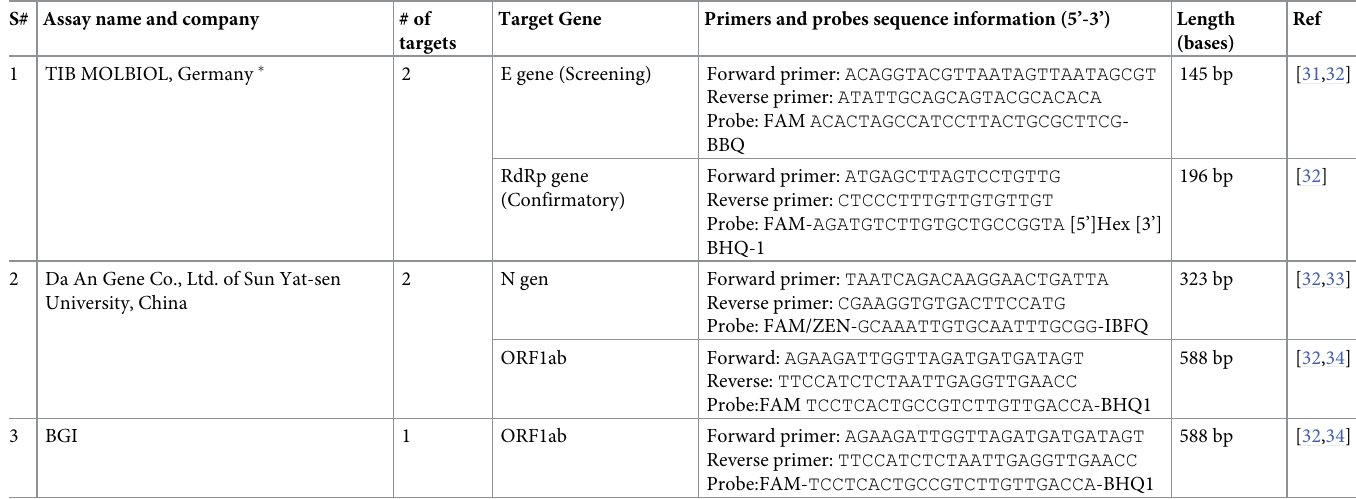
Table 1. RT-PCR test kits with their corresponding primers and probes sequences used in this study, Addis Ababa, Ethiopia, 2021. S# Assay name and